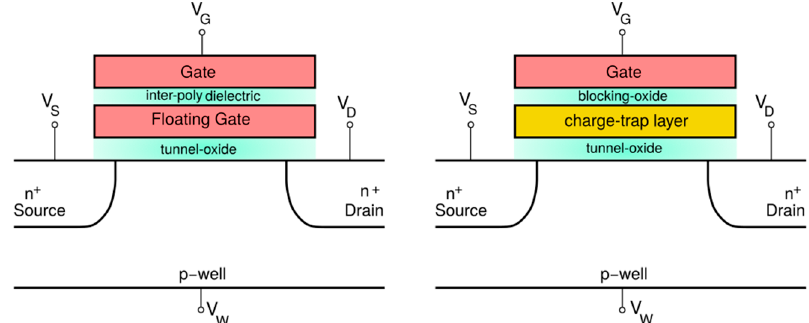
Figure 3. Schematic of a memory cell exploiting ( left ) a highly doped polysilicon layer and ( right ) a dielectric layer with a high density of microscopic defects for charge storage.